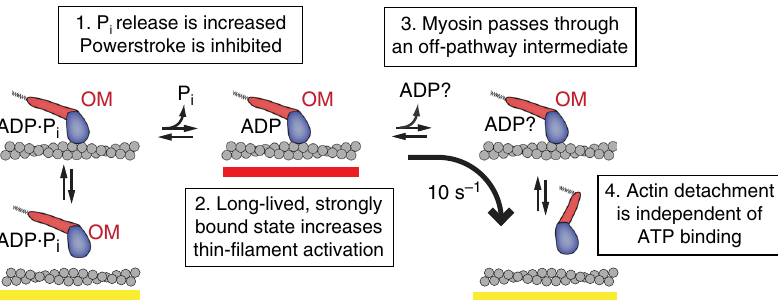
Fig. 6 Model of OM ’ s effect on cardiac myosin. (1) OM increases the rate of entry into strong binding as previously measured by phosphate release rates, but the force generating power stroke is inhibited. (2) Myosin remains strongly bound to actin (red bar), contributing to increased thin- fi lament activation at intermediate calcium concentrations. (3) OM disrupts the typical pathway of myosin, causing it to pass through an ADP or apo (nucleotide-free) state with its lever arm still in the pre-power stroke position. (4) Myosin detaches from actin without needing to bind ATP. ATP binding must occur before the cycle can start